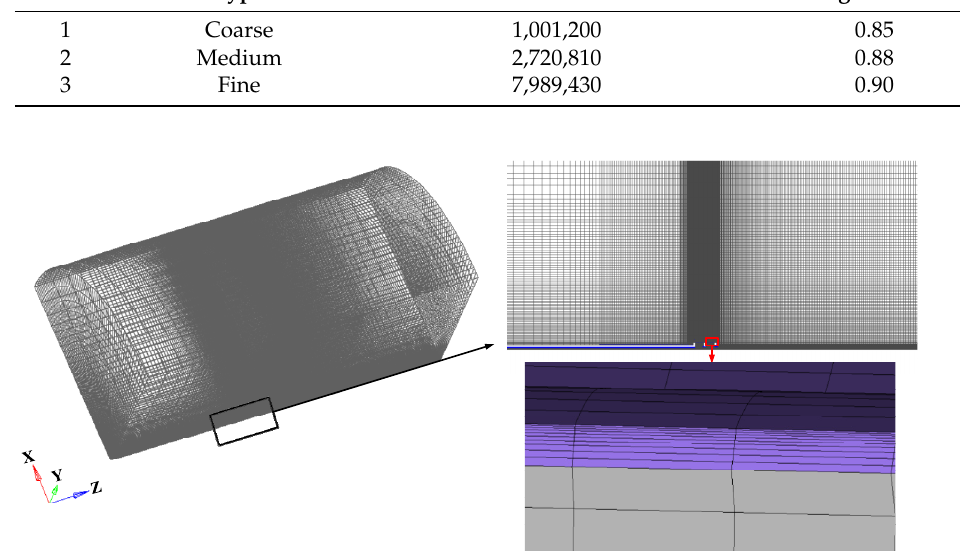
Figure 7. Computational grid model.